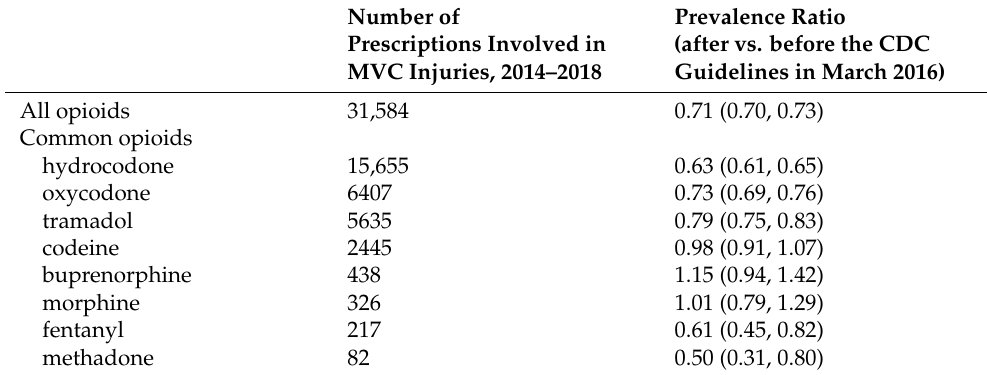
Table 2. Prevalence ratios for common prescription opioids after versus before CDC guidelines a